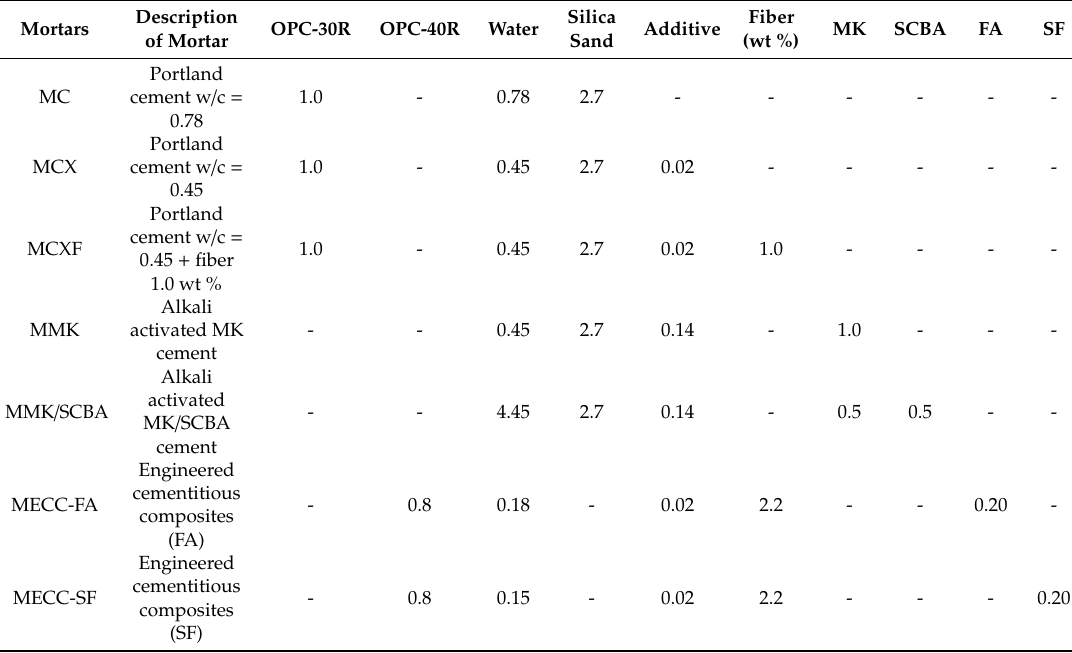
Table 3. Mortar mixture proportion